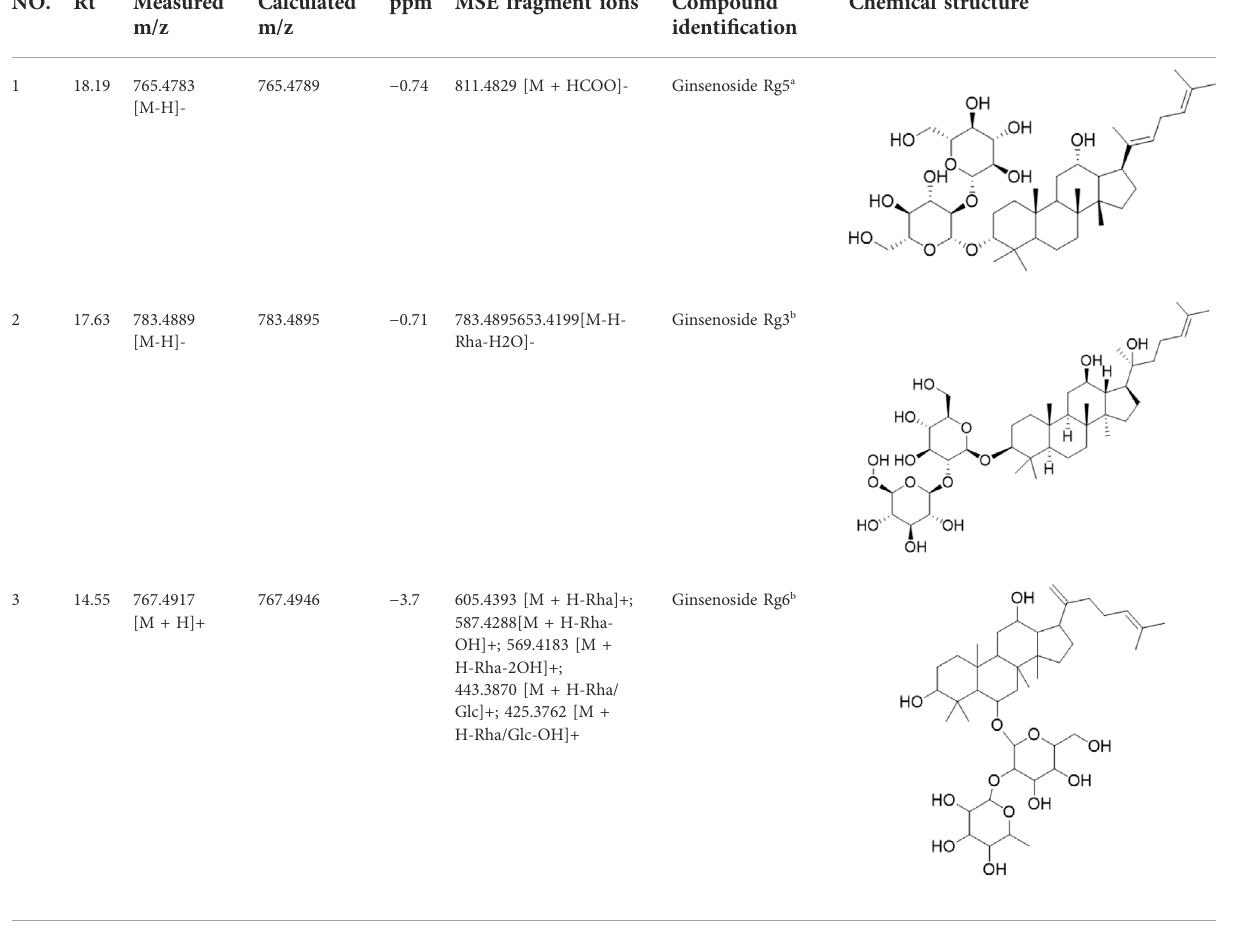
TABLE 4 Identi fi cation of differential active components from AG using the UHPLC-QE-Orbitrap-MS. NO.